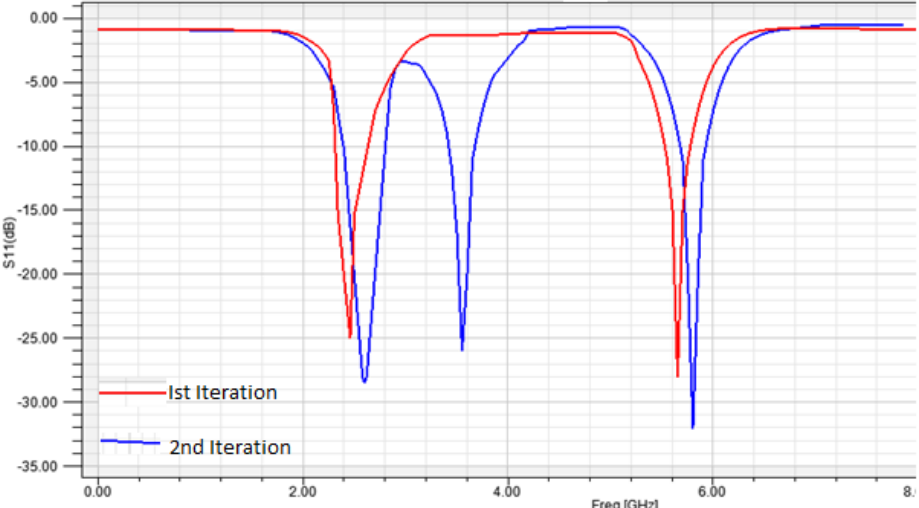
Figure 9. The consequence on the return loss parameter against the frequency for different antenna geometries described as first and second iteration fractal for the proposed antenna geometry.